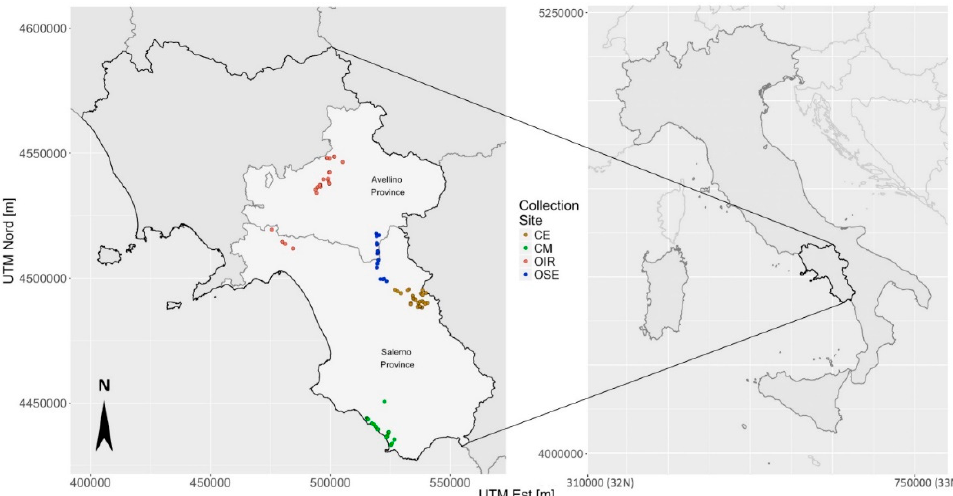
Figure 1. Geographic distribution of the 169 olive trees in Campania Region and corresponding tree collection sites [CE: Cilento hinterland (brown color), CM: Cilento coastal area (green color), OIR: olives of the Irpinia area (red color), OSE: olives along the Sele river (blue color)]. The projection system used to generate geographic maps is the Universal Transverse Mercator with the distances measured in meters (Table S1).